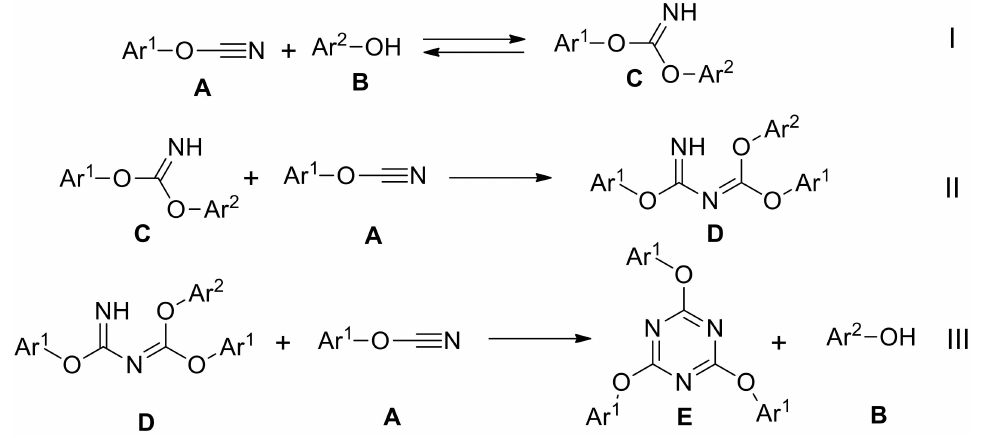
Figure 8. Mechanism of aryl cyanates